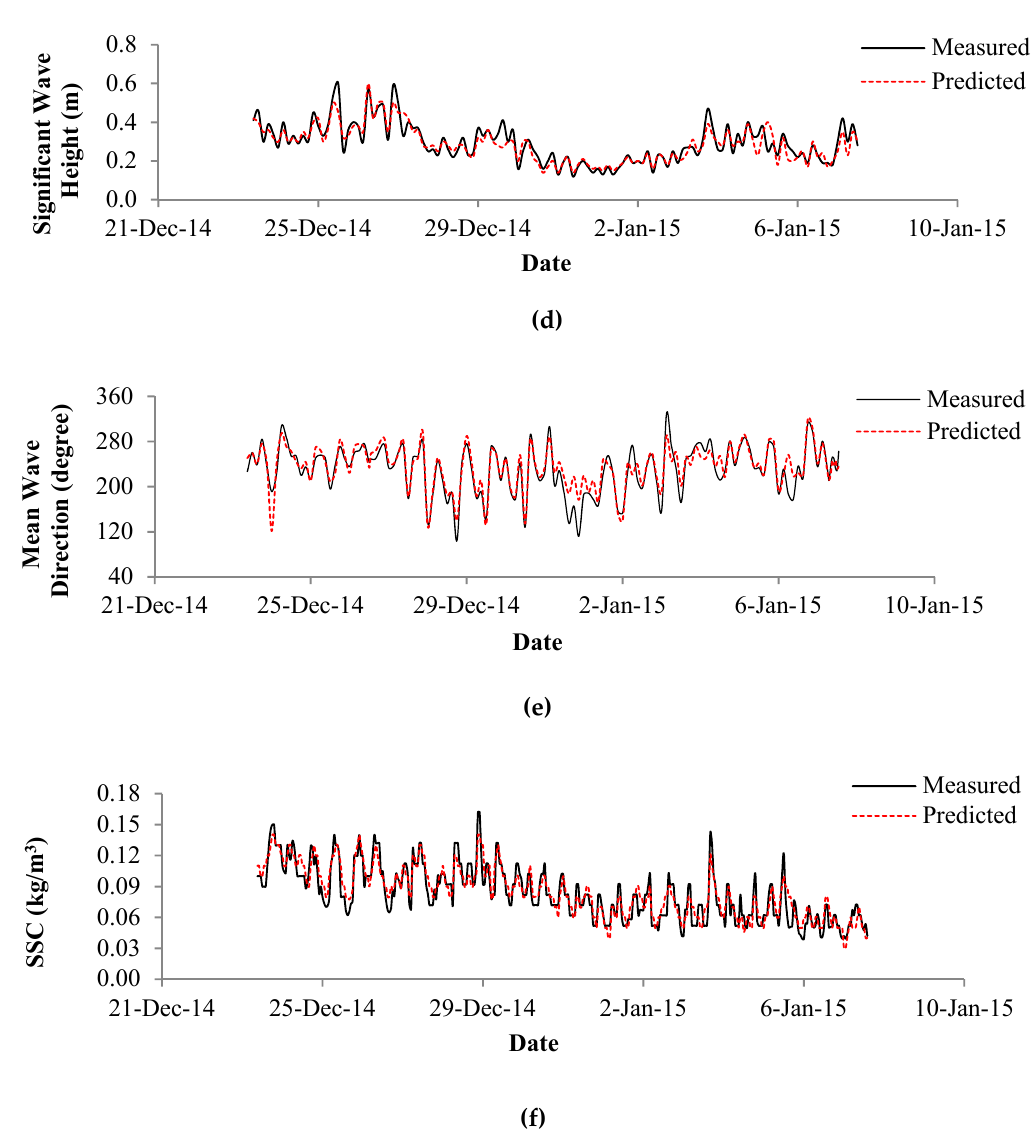
Figure 8. Comparison between simulation results and field measurements on 23 December 2014 to 7 January 2015 at station 2 (long: 101°18 ′ 58.14” E, lat: 02°49 ′ 26” N), ( a ) current speed; ( b ) current direction; ( c ) water level; ( d ) significant wave height; ( e ) mean wave direction; ( f ) SSC. Table 3. Statistical results for the performance of the hydrodynamic, wave and mud transport models.